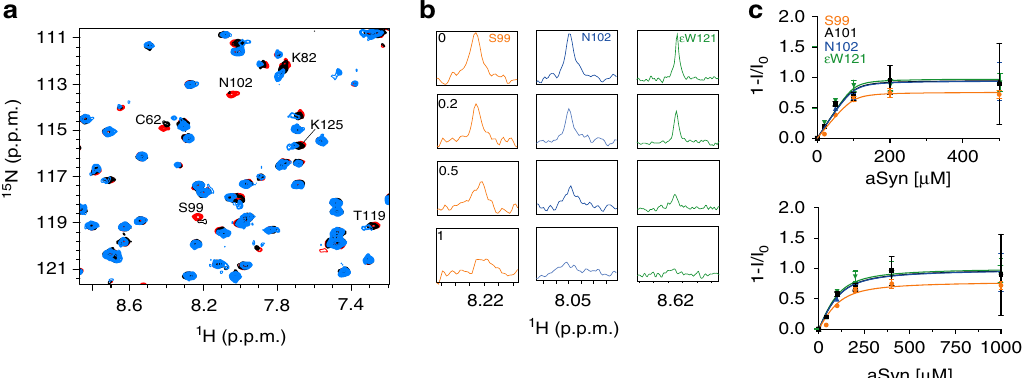
Fig. 2 CypA binds aSyn. a Superposition of selected regions of 1 H – 15 N HSQC spectra of 15 N-labeled CypA in the presence of increasing aSyn concentrations (CypA:aSyn molar ratios of 1:0, 1:1, and 1:5 in red, black, and light blue, respectively). b One-dimensional 1 H traces through selected 1 H – 15 N cross-peaks (S99, N102, and ε W121) of CypA in the presence of increasing concentrations of aSyn. aSyn:CypA molar ratios are indicated in the S99 panels. c Intensity changes of cross-peaks in CypA, which have predominantly slow-exchange behavior in the presence of increasing aSyn concentrations. Error bars were derived from signal-to-noise ratios in the NMR spectra of each titration experiment. Lines represent global fi ts to the experimental data assuming a reversible 1-to-1 binding